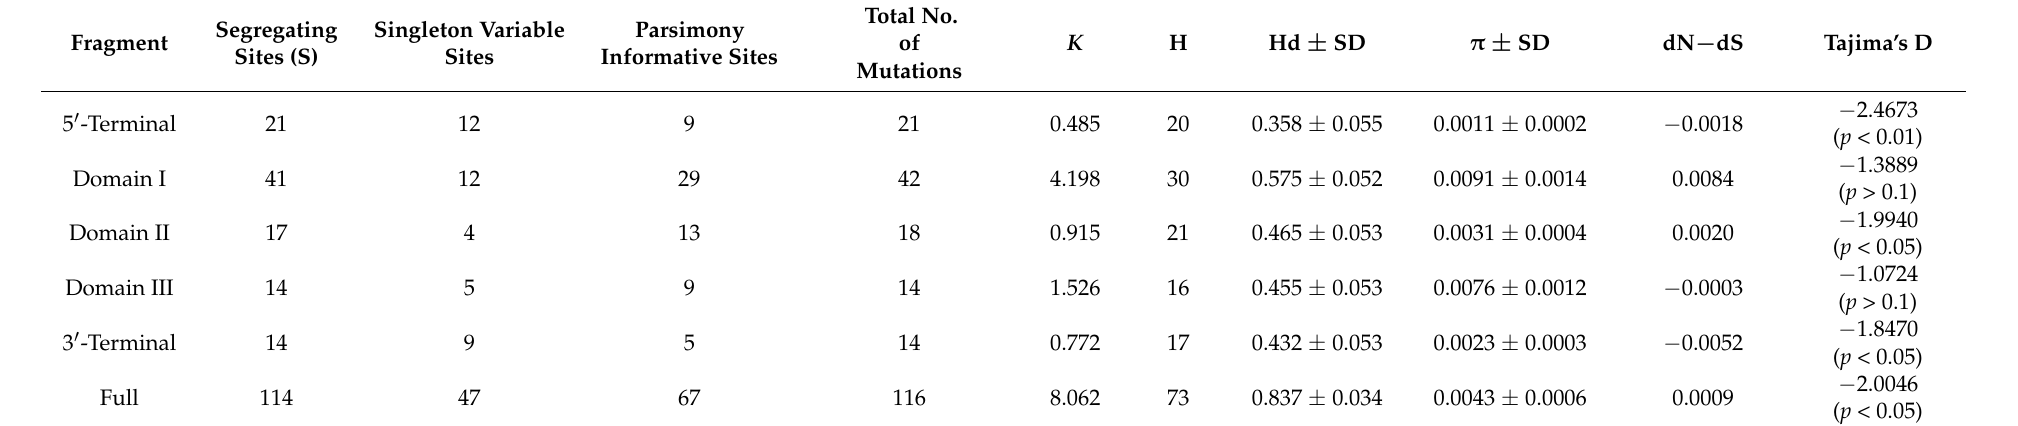
Table 1. Estimates of DNA sequence polymorphism, and tests of neutrality at pfama-1 among P. falciparum Vietnam